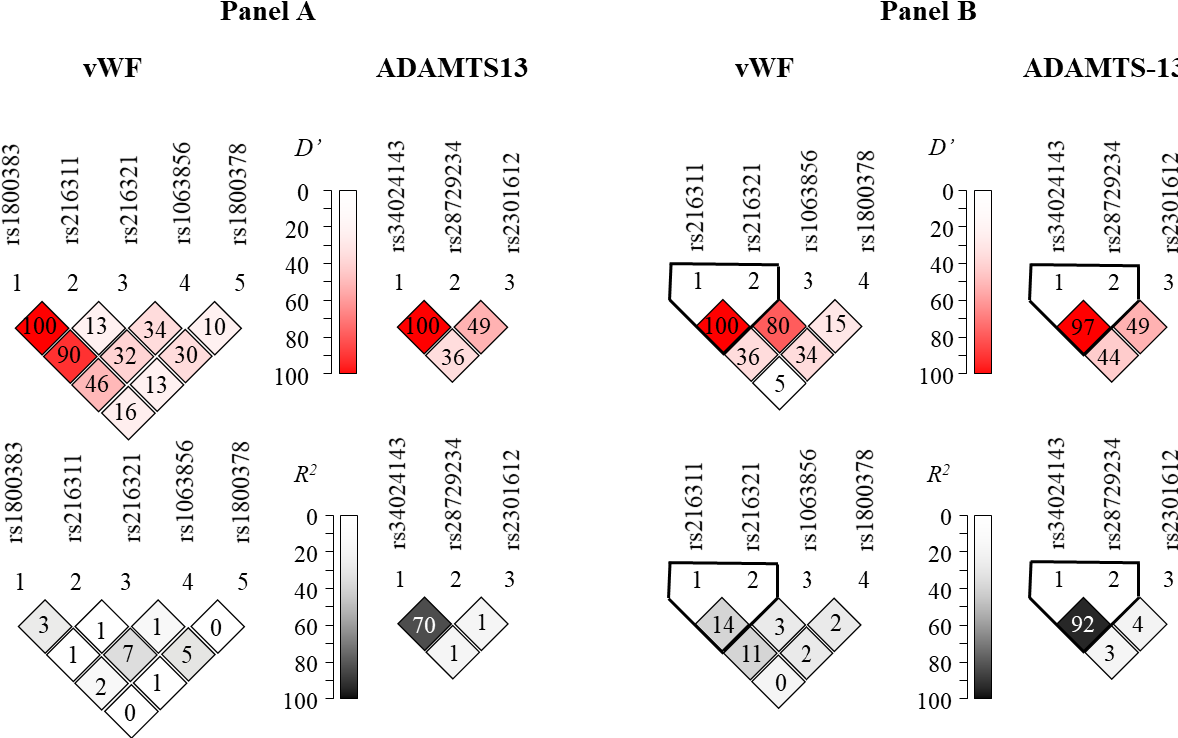
( left column ) and ADAMTS13 ( right column ) genes ( Panel A ). Panel B represents linkage disequilib-